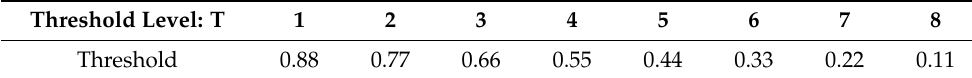
Table 6. Threshold level and the threshold correspondence.